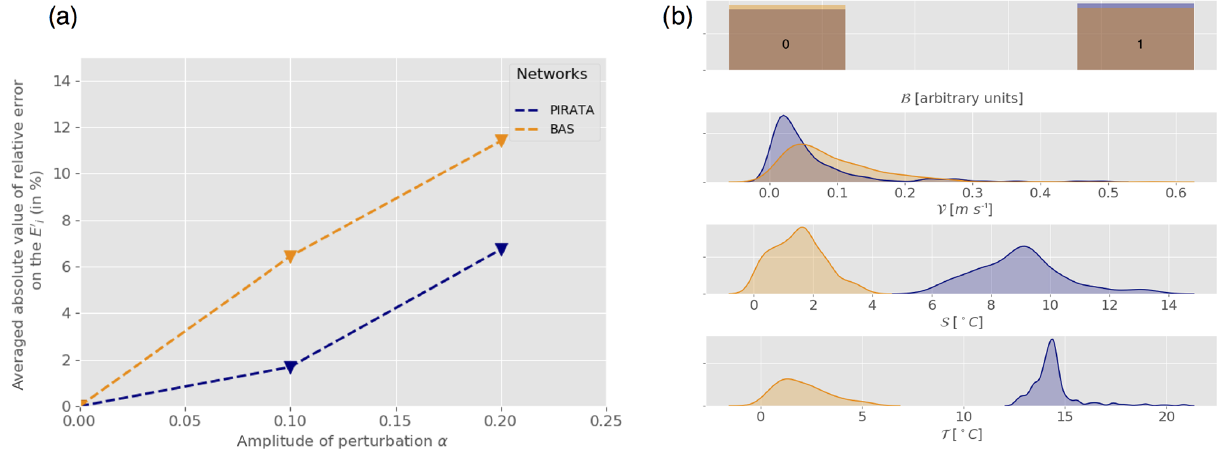
Figure 8. (a) Mean relative error on the coefficients E r (in %, Eq. 9) as a function of the perturbation amplitude α (Eq. 8) for PIRATA (blue) and BAS (orange) observation networks. (b) Statistical distribution of all PIRATA (blue) and BAS (orange) observation location indi- cator variables: bloom index ( B ), velocity norm ( V ), stratification index ( S ) and temperature ( T ) estimated using kernel density estimation (Silverman,